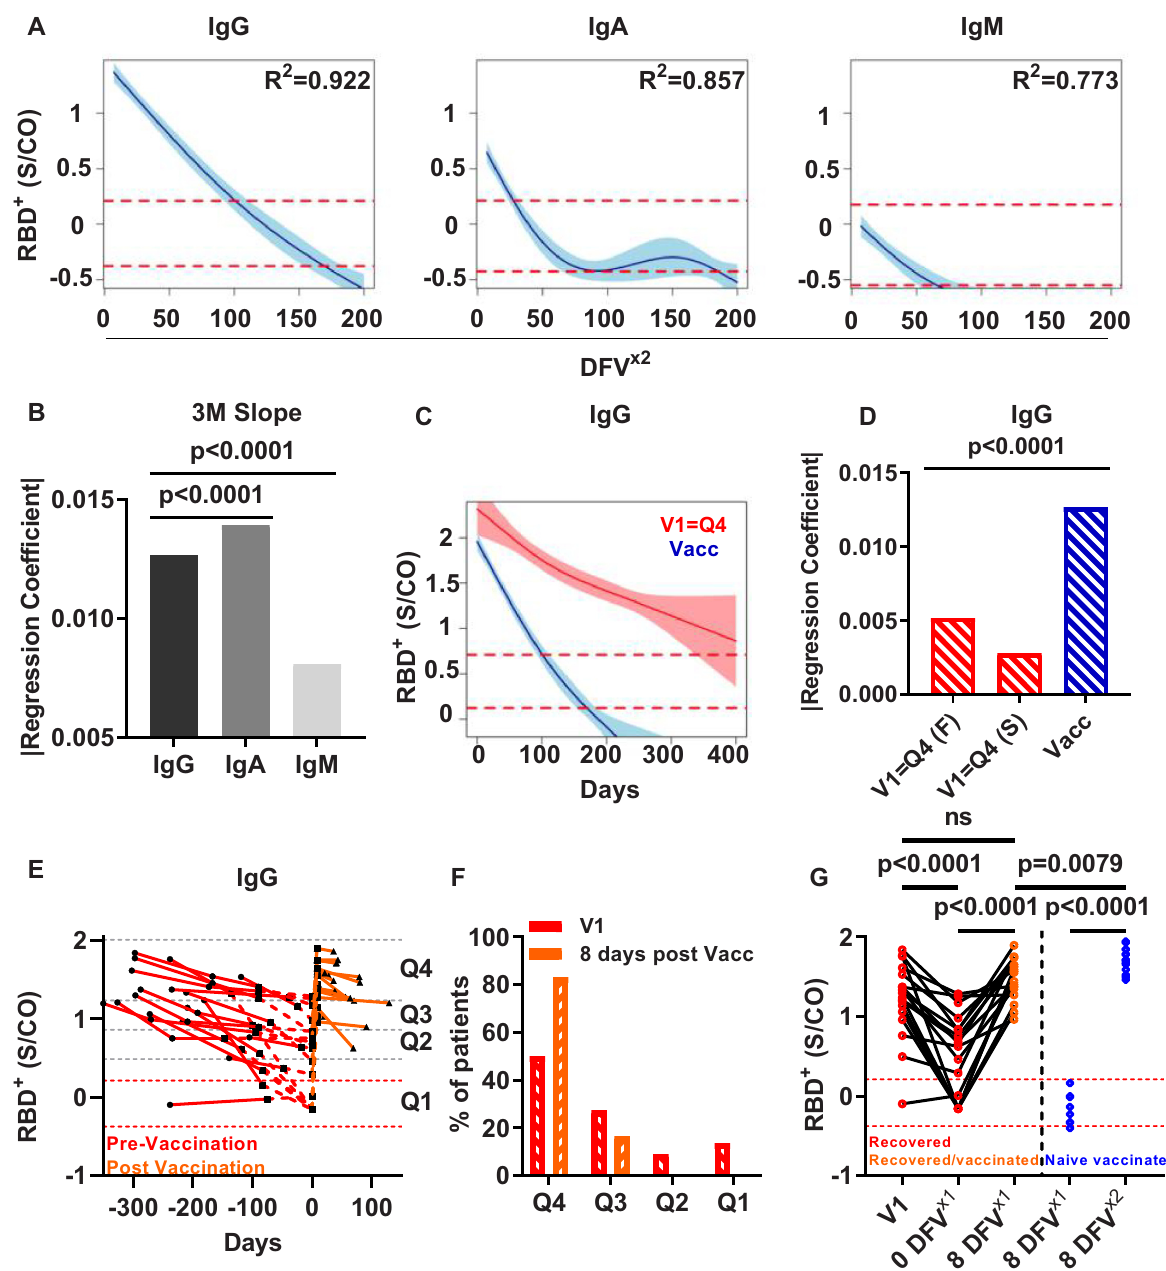
Fig 6. RBD + antibody longitudinal kinetics in na ï ve vaccinees and recovered/vaccinated patients. (A) RBD + IgG/A/M longitudinal kinetics in na ï ve vaccinees following two vaccine doses (n = 17). GAMM analysis was applied, and regression coefficient was determined. The 95% CI is shown in turquoise. Y-axis log 10 and X-axis show days following vaccination (DFV x2 ). Dashed red lines indicate the upper and lower limit of negative control samples (n = 27). (B) Bar plot comparing the regression coefficient obtained for IgG, IgA, and IgM during the 90 DFV x2 (3 months following vaccine, 3M slope). For all plots R 2 is indicated, and p value, slopes, and effective degree of freedom (edf) can be found in S2 Table. p values < 0.05 were considered significant. (C) RBD + IgG longitudinal kinetics in na ï ve vaccinees in comparison with the kinetics in recovered patients whose IgG levels were assigned to Q4 at V1. Y-axis log 10 shows IgG levels (S/CO), x-axis shows DFS for recovered patients (red) and DFV x2 for na ï ve vaccinees (blue). (D) Multiple comparison analysis of the regression coefficients obtained for the fast decay (F) and slow (S) decay rate in recovered patients and na ï ve vaccinees. Y-axis represents the absolute regression coefficient values. (E) Utilizing each patients’ regression model pre-vaccination and the known vaccination day, the RBD + IgG level was extrapolated to predict the IgG level on the day of vaccination (0 DFV x1 ). IgG levels post vaccination at V4 were used to extrapolate the antibody levels for 8 DFV x1 . Y-axis represents the RBD + IgG levels in log 10 , x-axis represents days in relation to the day of vaccination (i.e. 0 DFV x1 ). Dashed red lines indicate the upper and lower limit of negative control